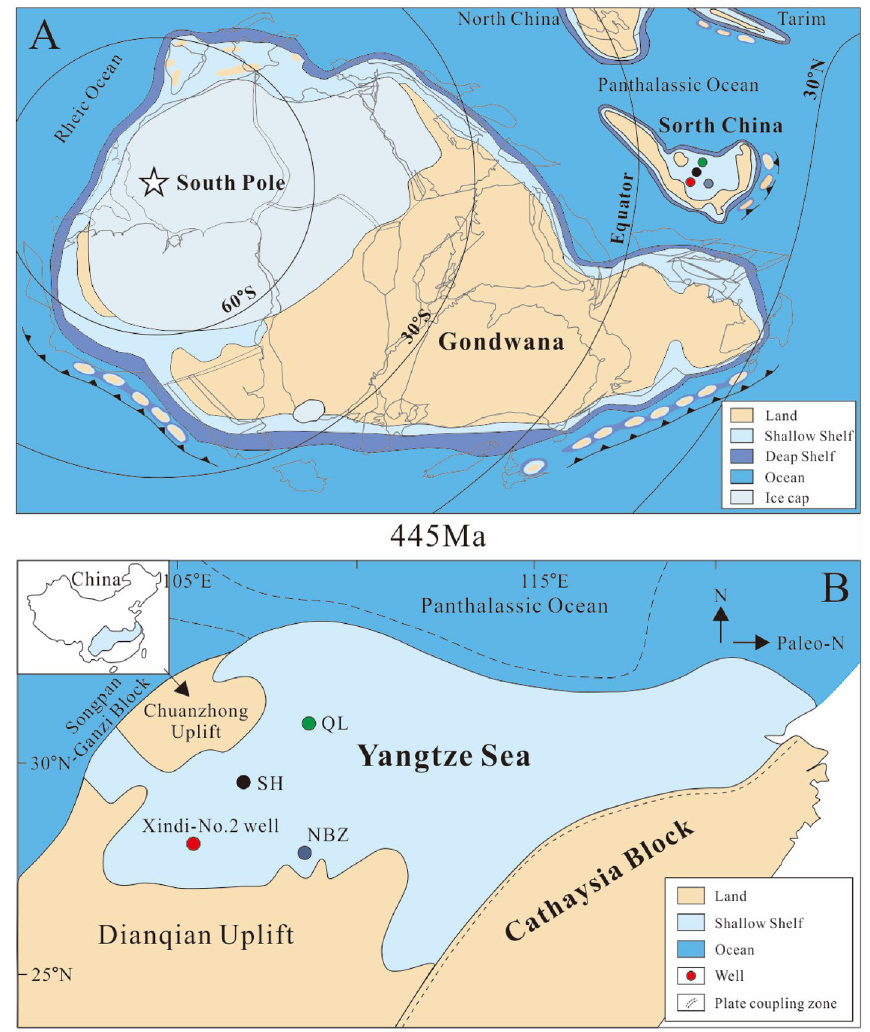
Figure 1. Geological setting. ( A ) Late Ordovician (445 Ma) palaeogeography with the location of South China (adapted from Torsvik and Cocks 45 ). Red circle represents the Xindi-No. 2 well. ( B ) Simplified